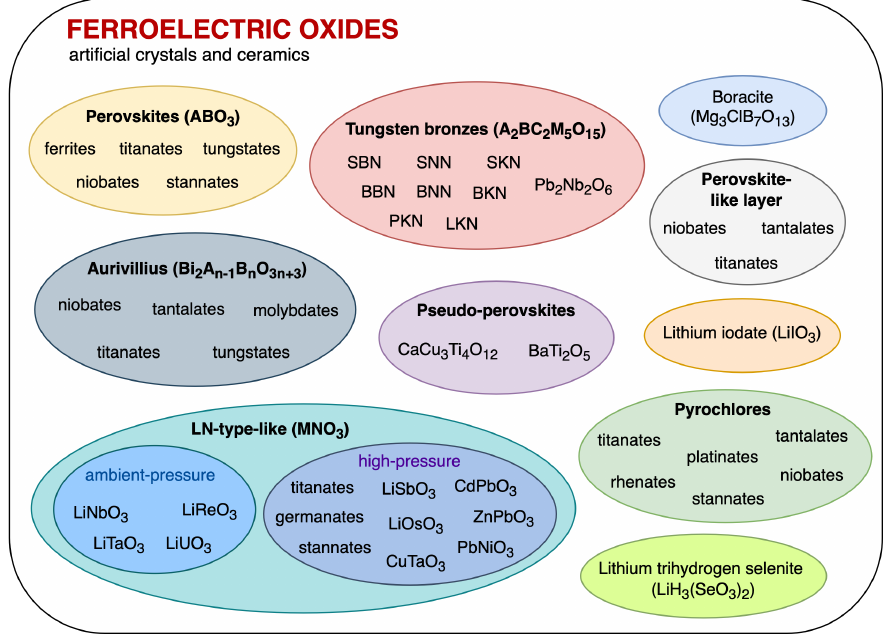
Figure A1. The class of ferroelectric oxides consisting in perovskites, tungsten bronzes, perovskite-like layer, pyrochlores, Aurivillius phase and LN-type-like